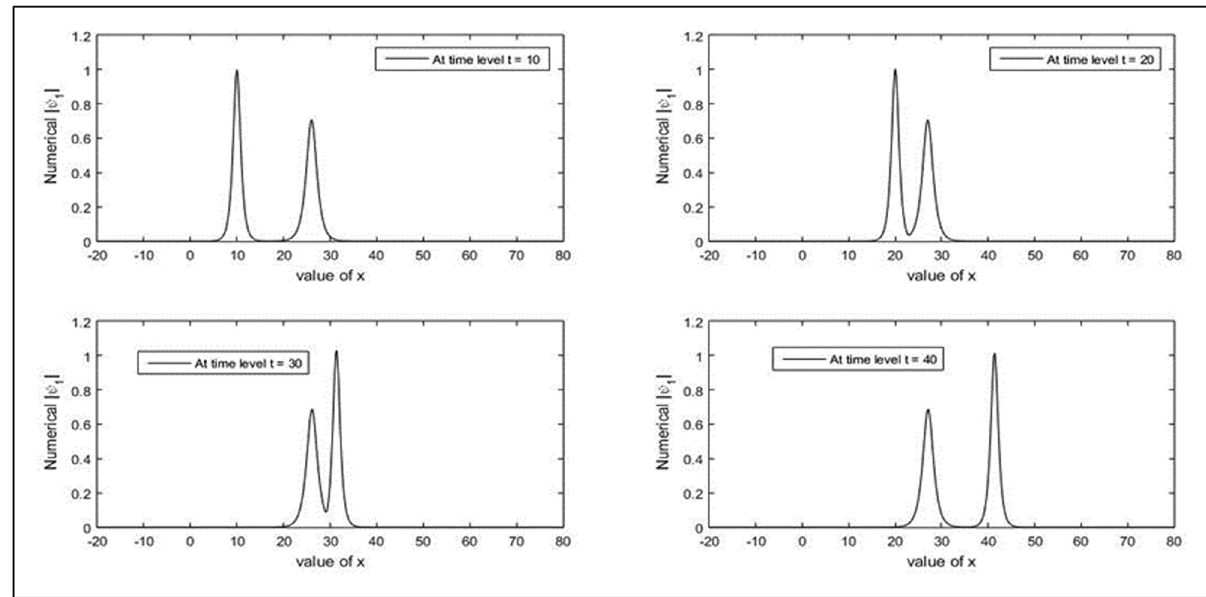
Figure 7: Interaction of two solitons for fi rst - wave amplitude for = N 501